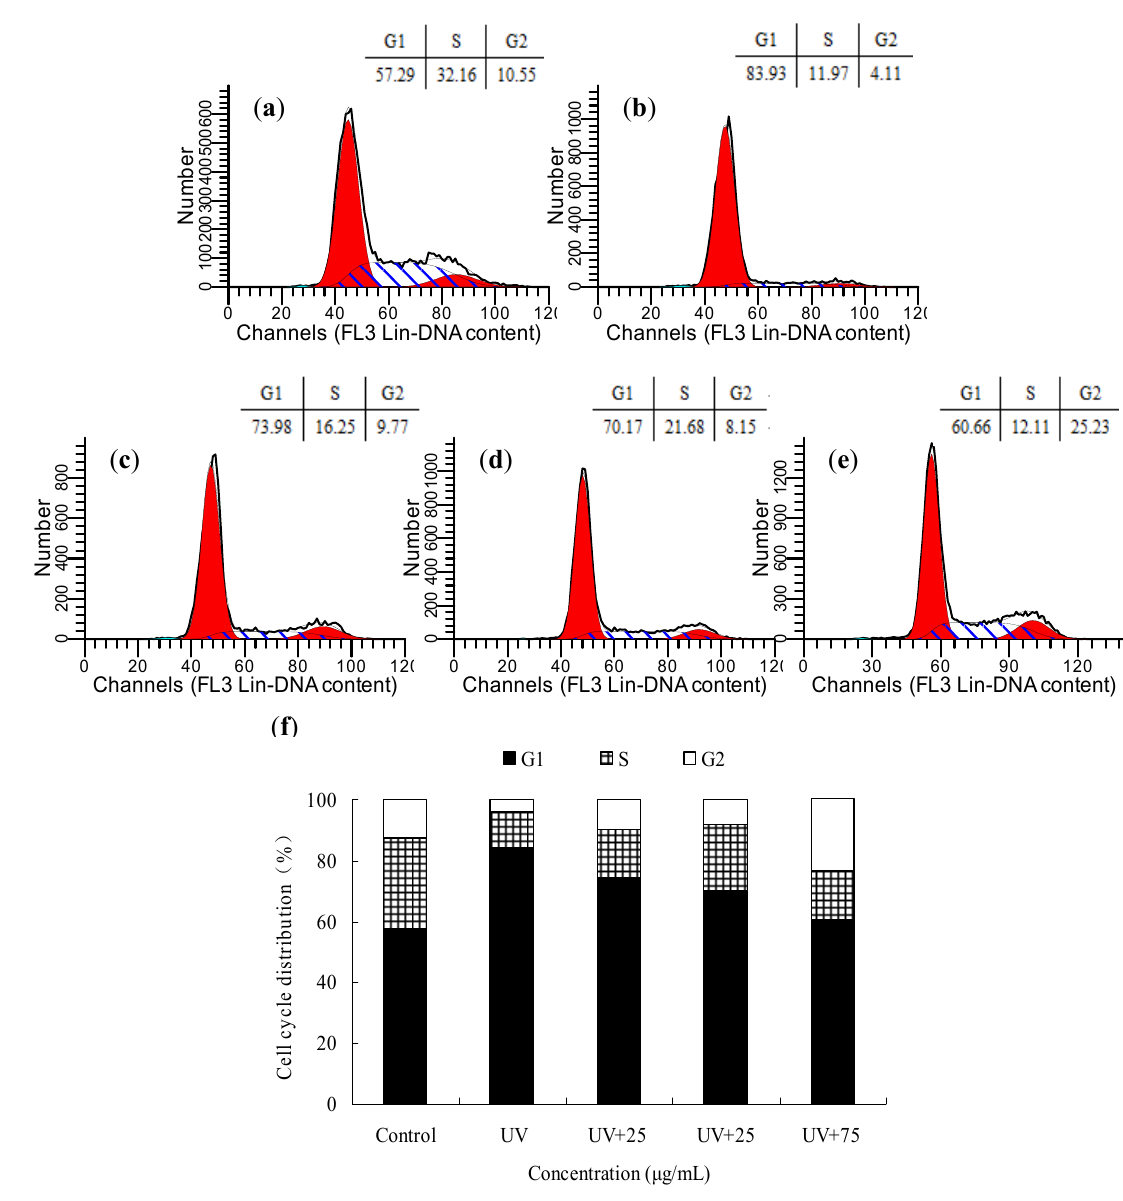
Figure 4. The effects of BA on the cell cycle distribution of UV-irradiated HepG2 cells. After pre-treatment for 12 h with BA, at different concentrations, and then exposed to UV, cell cycle analysis of propidium-iodide stained nuclei was performed by flow cytometry. ( a ) control (without UV radiation); ( b ) UV-radiation without extracts; ( c , d , e ) were UV+ 25 μ g/mL BA, UV+ 50 μ g/mL BA, UV+ 75 μ g/mL BA, respectively; ( f ) percentage of treated HepG2 cells in varied phase.